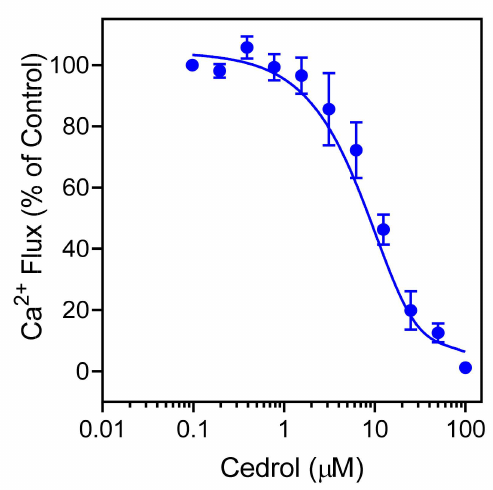
Figure 3. Inhibition of f MLF-induced neutrophil Ca 2+ mobilization by (+)-cedrol. Human neutrophils were treated with the indicated concentrations of (+)-cedrol or 1% DMSO (negative control) for 10 min. The cells were activated by 5 nM f MLF, and [Ca 2+ ] i was monitored, as described. The data are from one experiment that is representative of three independent